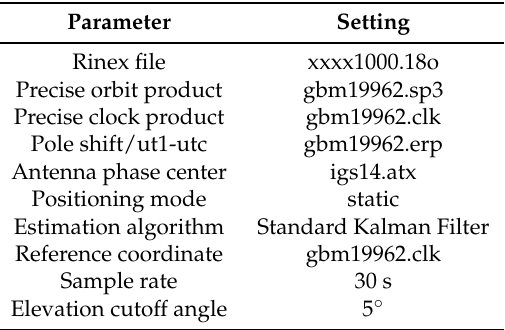
Table 4. Parameter settings.